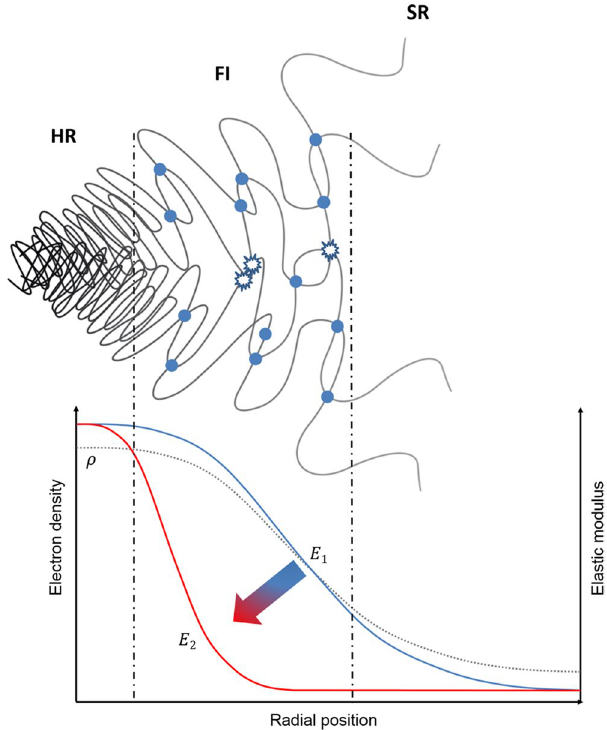
Figure 5. Schematic diagram showing softening mechanism of fuzzy interface. The overall softening process causes gradual destruction of the physical cross-links across the fuzzy interface zone, where the electron density drops steeply from the HR to SR value. This leads to a strong variation of material stiffness as a function of deformation in the fuzzy interface region (FI), whereas the stiffness values in the HR and SR remain largely